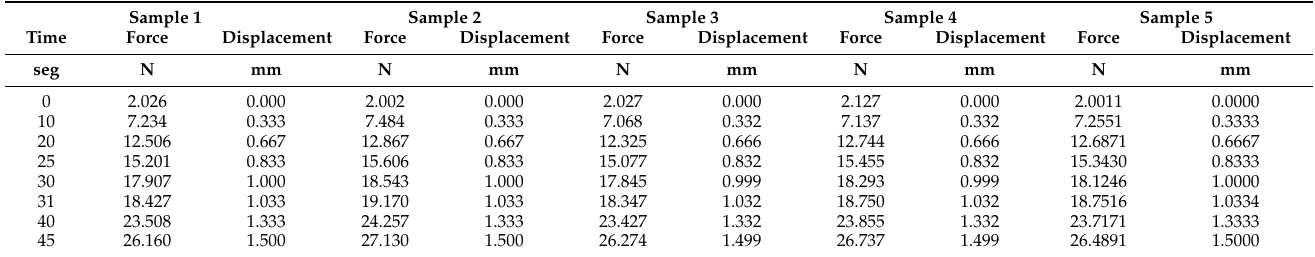
Table 7. Displacement values for flexural test.